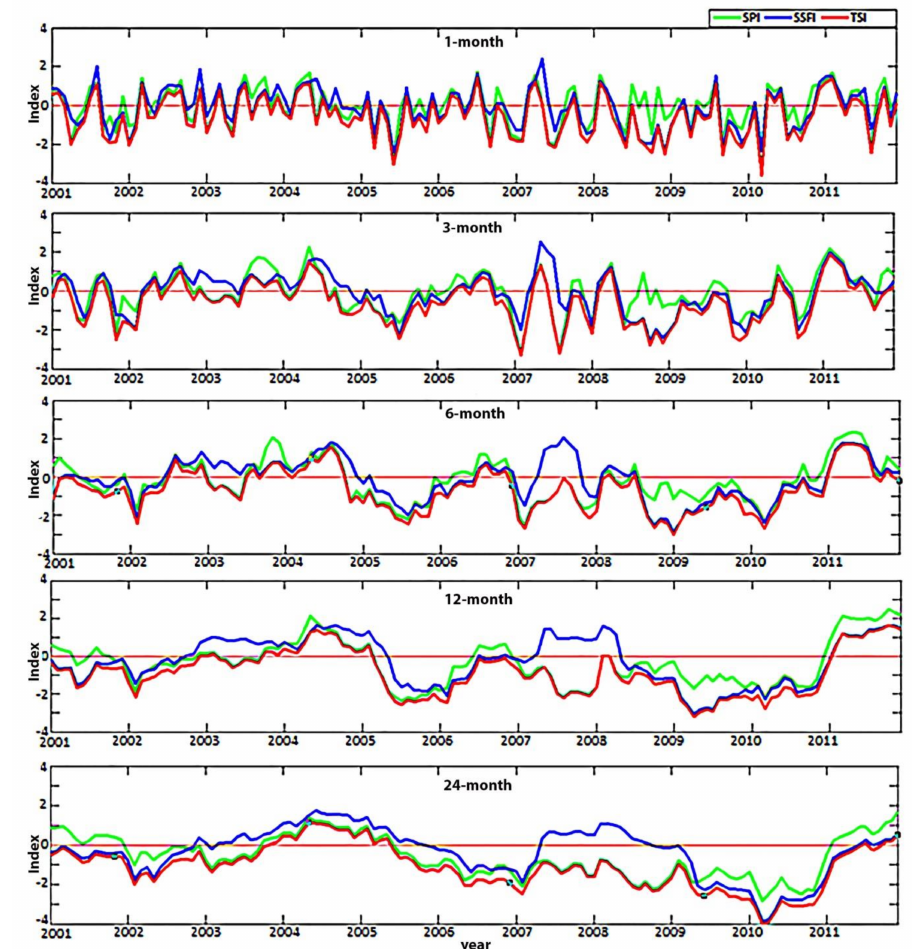
Figure 7. Comparison of SPI, SSFI, and TSI at 1-, 3-, 6-, 12-, and 24-month time scales for the Rasht